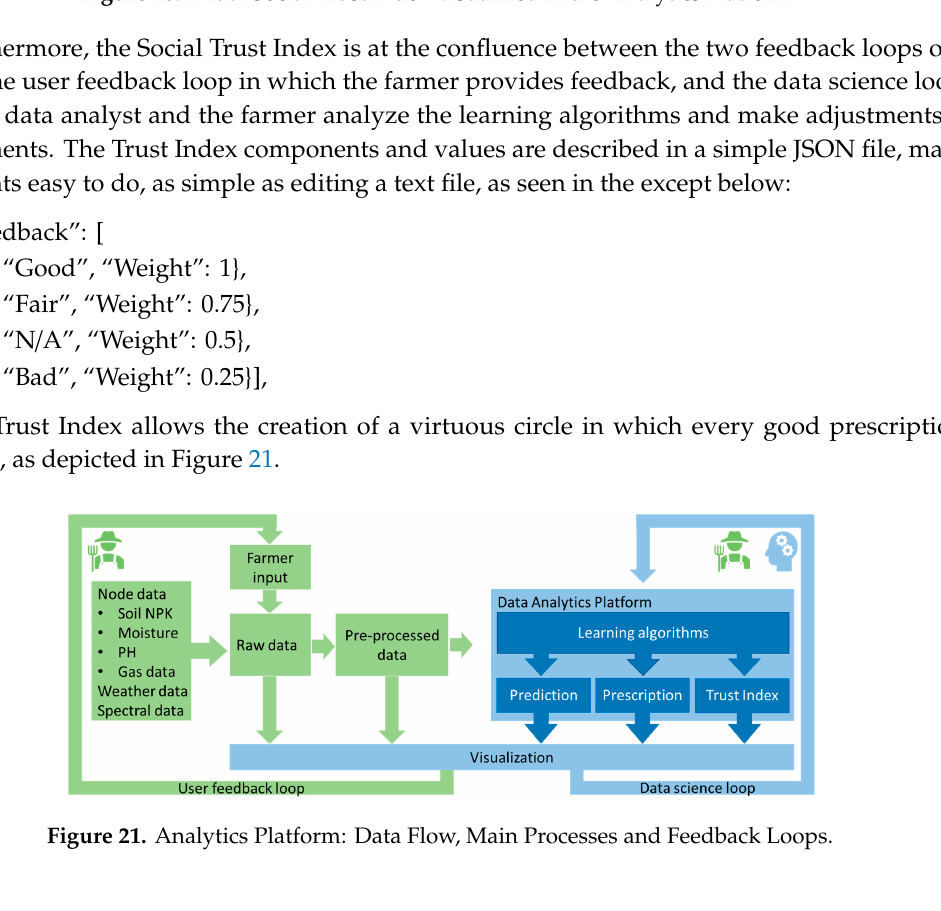
Figure 20. Initial Social Trust Index Visualized in the Analytics Platform.